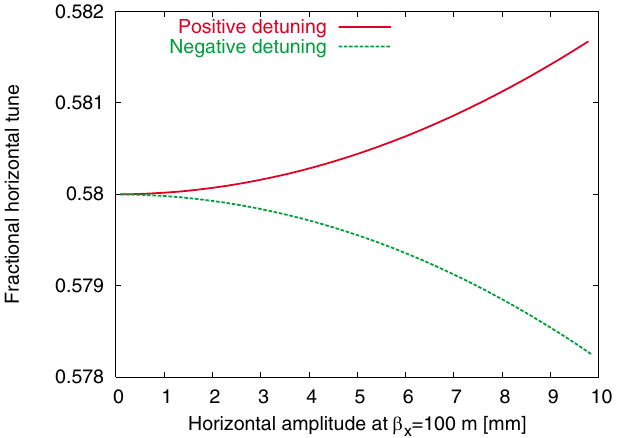
FIG. 3. (Color) Amplitude of the natural oscillation of the par- ticle normalized to the amplitude of the forced oscillation in the flattop versus the number of turns used to ramp the excitation for negative, positive, and zero amplitude